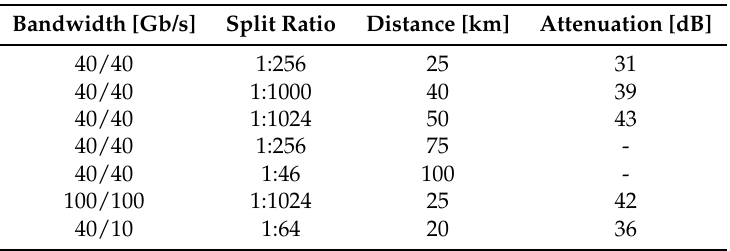
Table 1. Overview made implementations of TWDM